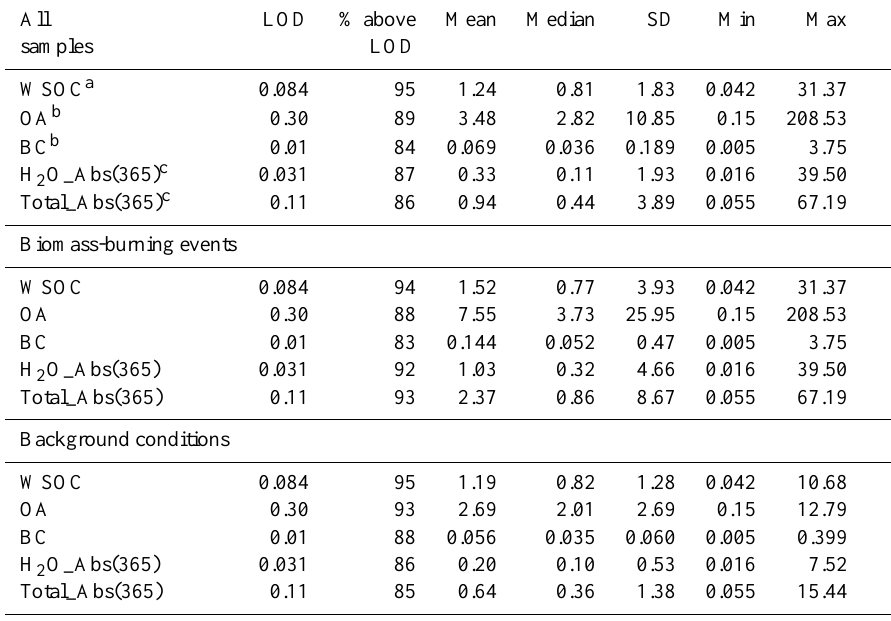
Table 3. Statistical summary of observed species throughout all flights during DC3 separated into three categories: all samples, samples during identified biomass-burning events and samples for background conditions (periods when data could not be clearly identified as biomass burning). For statistical purposes, one-half the LOD value is substituted for data below LOD. All data have been merged to the nominally 5min filter sampling time. All LOD % above Mean Median SD Min Max samples LOD WSOC